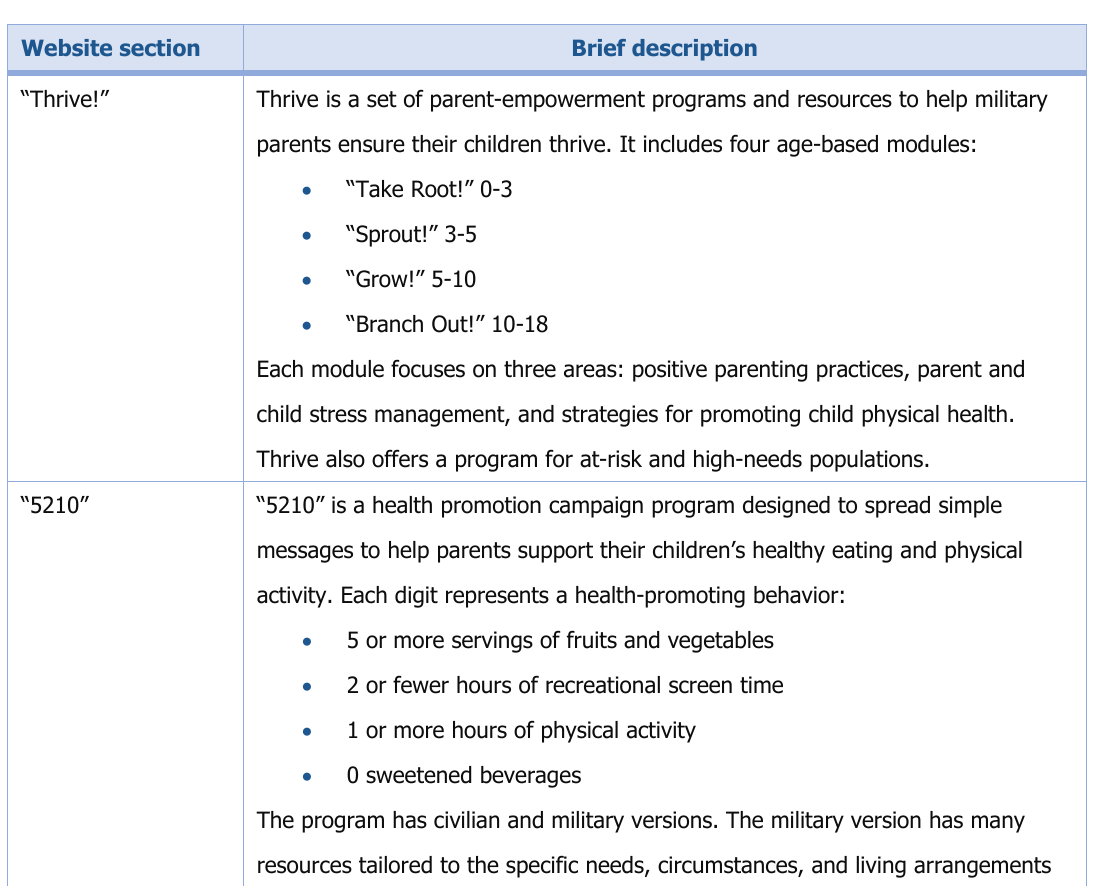
Table 3. Clearinghouse Website “Resources”